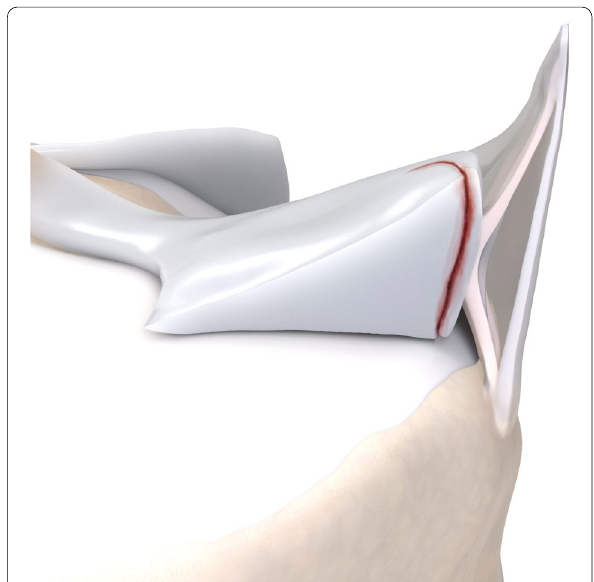
Fig. 10 Type 4A meniscal ramp lesion illustration, defined as complete peripheral posterior horn meniscal tear